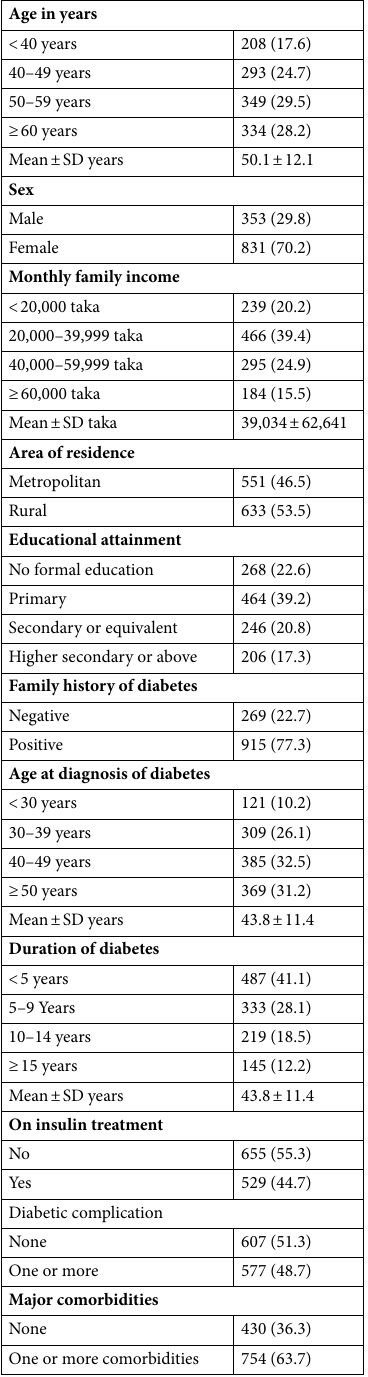
Table 1. Characteristics of the participants (n =